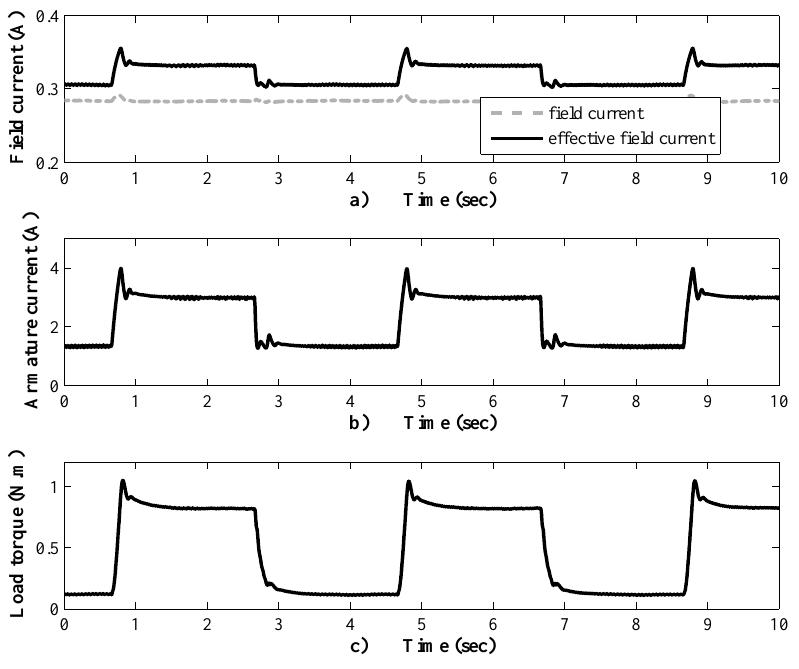
Figure 7. SOSM controller monitoring signals: ( a ) field current i f and effective field current i ef f , ( b ) armature current i a , and ( c ) load torque T L .